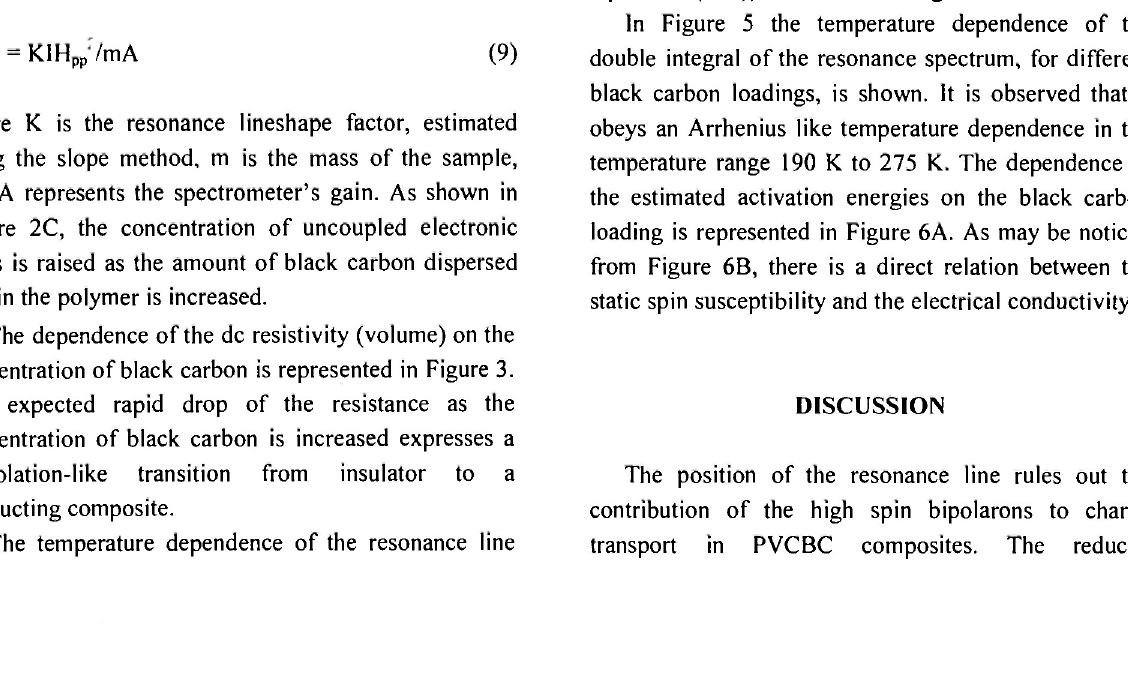
Fig. 3: A. The dependence of the electrical resistance on black carbon concentration. B. The dependence of the logarithm of electrical resistance on black carbon concentration. The line represents the best fit obtained within the percolation approach (Eq.